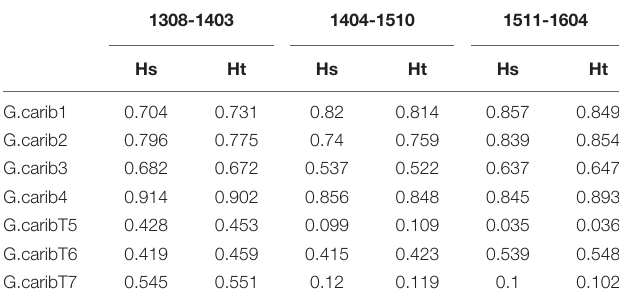
TABLE 4 | Allele diversity within months (Hs) and total allele diversity (Ht) for each microsatellite locus during the high-resolution sampling period at